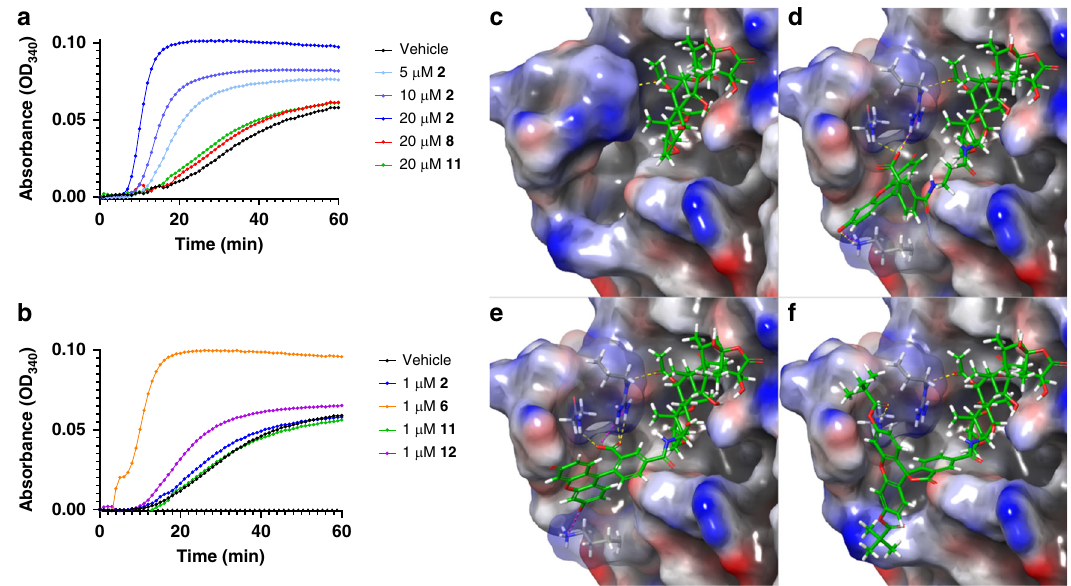
Fig. 5 Taccalonolide probes engage additional β -tubulin contacts. a , b Effects of free taccalonolide AJ ( 2 ) and taccalonolide- fl uorescein probes ( 6 , 8 , 11 , 12 ) on the polymerization of puri fi ed porcine tubulin. a Concentration-dependent (5 – 20 μ M) effects of 2 on tubulin polymerization with vehicle in black and 2 in shades of blue from lightest to darkest as concentration increases. The introduction of pivaloyl protecting groups in 8 (red) and 11 (green) diminish this activity even at equimolar concentrations with tubulin (20 μ M). b The deprotected taccalonolide probes 6 (orange) or 12 (purple) are more potent than 2 (blue) or 11 (green) in their ability to polymerize puri fi ed tubulin. c – f Comparison of the published structure 5EZY ( 2 bound to β -tubulin) c with a model of β -tubulin docked to taccalonolide probes ( 6 ) d , ( 12 ) e , and ( 11 ) f . The selected H-bonds and salt bridges are displayed as yellow and magenta dashed lines, respectively. Source data are provided as a Source Data fi